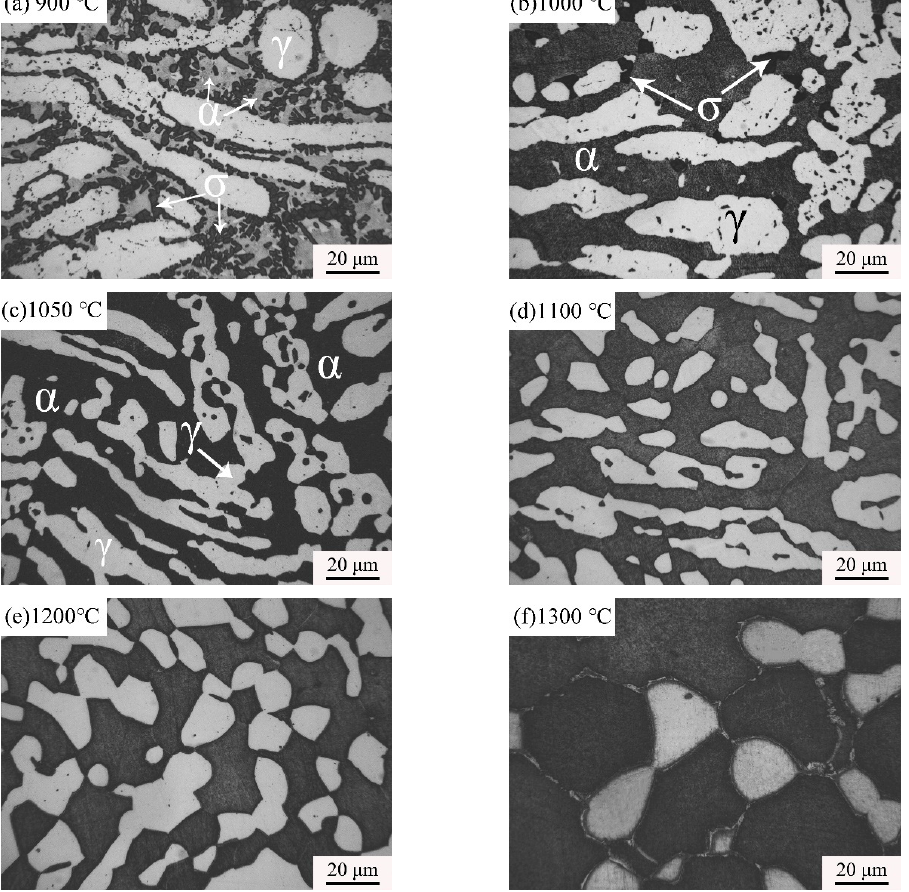
Figure 2. Microstructures of the UNS S32750 super duplex stainless steel treated at di ff erent solution treatment temperatures. ( a ) 900 ◦ C; ( b ) 1000 ◦ C; ( c ) 1050 ◦ C; ( d ) 1100 ◦ C; ( e ) 1200 ◦ C; and ( f ) 1300 ◦